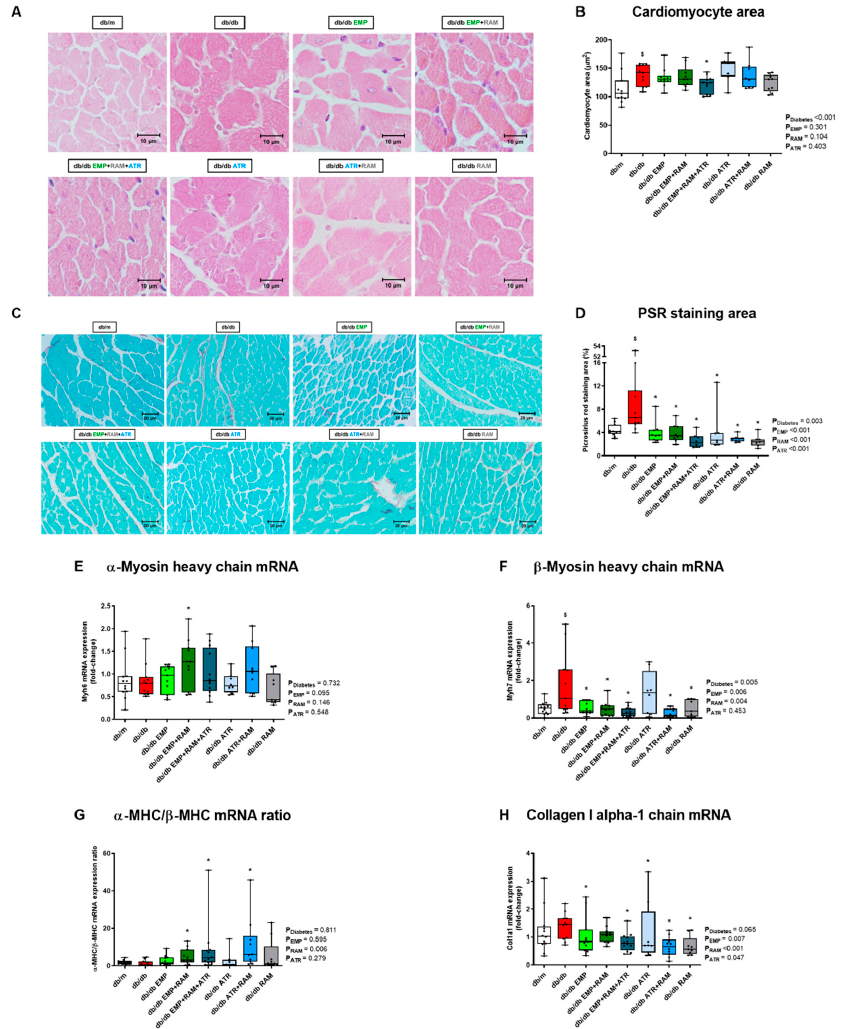
Figure 4. Left ventricle cardiomyocyte hypertrophy, fibrosis, and gene expression of α -MHC, β - MHC and collagen I alpha-1 chain in vehicle-treated db/m mice, vehicle-treated db/db mice, and db/db mice treated with empagliflozin, atrasentan, ramipril, or their combinations . ( A ) Repre- sentative hematoxylin-eosin microphotographs of transversally sectioned cardiomyocytes (×400 magnification). ( B ) Cardiomyocyte transversal area in µm 2 measured in H&E-stained sections. ( C ) Representative Picrosirius-red-stained left ventricle sections (×400 magnification). ( D ) Left ventricle Picrosirius-red-stained area in µm 2 . ( E ) mRNA expression of α -myosin heavy-chain ( α -MHC). ( F ) mRNA expression of β -myosin heavy-chain ( β -MHC). ( G ) α -MHC/ β -MHC ratio. ( H ) mRNA expression of collagen I alpha-1 chain. An almost significant increase in collagen I expression was observed in the vehicle-treated db/db group vs. the db/m : non-diabetic mice treated with vehicle. db/db : diabetic mice treated with vehicle. db/db EMP : diabetic mice treated with empagliflozin. db/db EMP + RAM : diabetic mice treated with empagliflozin and ramipril. db/db EMP + RAM + ATR : diabetic mice treated with empagliflozin, ramipril, and atrasentan. db/db ATR : diabetic mice treated with atrasentan. db/db ATR + RAM : diabetic mice treated with atrasentan and ramipril. db/db RAM : diabetic mice treated with ramipril. Factorial ANOVA main effect results are displayed next to the graph. P Diabetes : diabetes’ main effect. P EMP : empagliflozin’s main effect. P RAM : ramipril’s main effect. P ATR : atrasentan’s main effect. $ p < 0.05 vehicle-treated db/db mice vs. vehicle-treated db/m mice. * p < 0.05 any treated db/db mice compared with vehicle-treated db/db